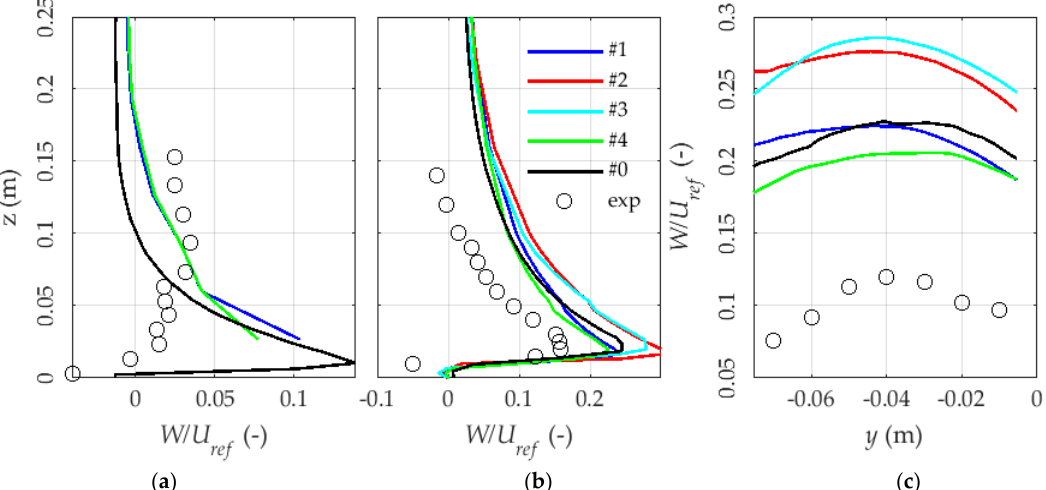
Figure 8. Mean vertical wind velocity at the rooftop of the Muirhead tower ( a ) and Biosciences building ( b , c ), normalized against U ref .